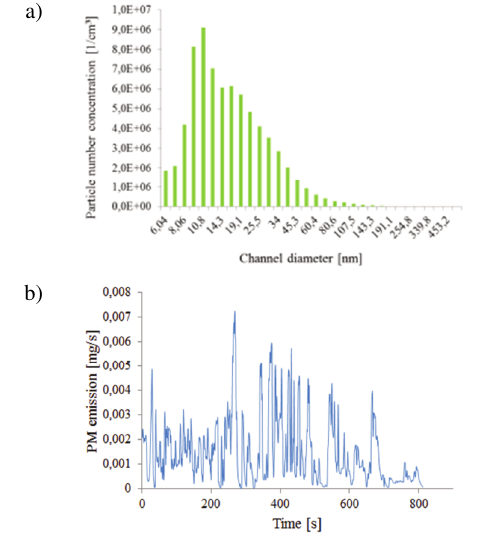
Fig. 10. Solid components of exhaust gases: a) particle number concentra- tion, b) particle mass